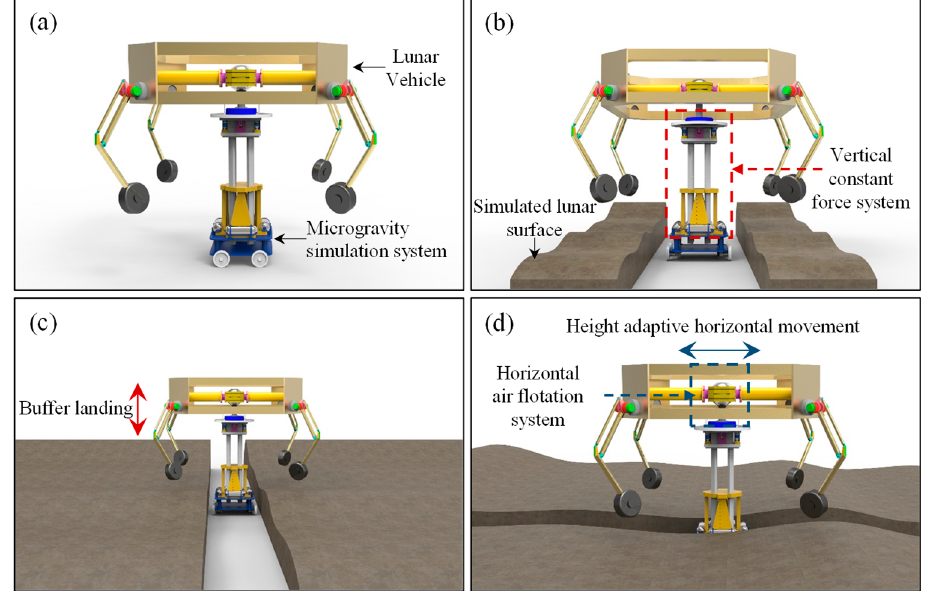
Figure 2. Three-dimensional schematic diagram of micro-low-gravity simulation system structure. ( a ) system architecture, ( b ) lunar vehicle infield test, ( c ) buffer landing simulation, ( d ) horizontal movement simulation.